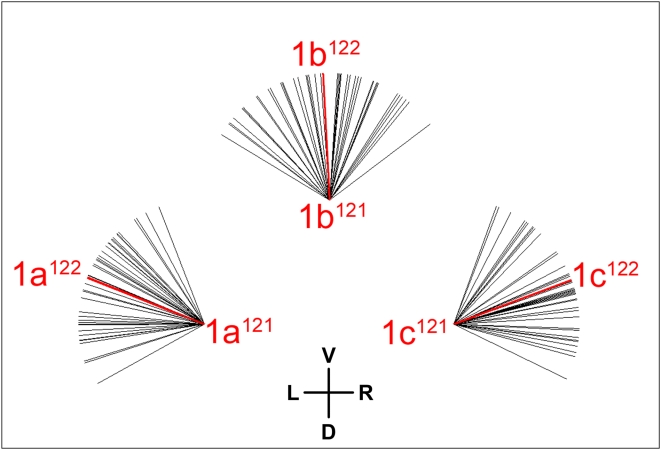
Dorsoventrally polarized division axes in the 1abc12 cell group.The orientation of each black line represents the axis between a single pair of 1abc121/1abc122 sister nuclei (41 embryos total), with the secondary axis of the embryo oriented vertically. Red lines mark mean division axis for each cell. The 1ac122 nuclei tend to be positioned more ventrally than their 1ac121 sisters.